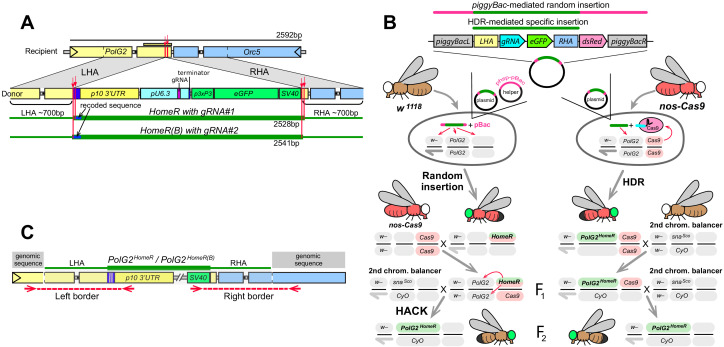
Site-specific integration of HomeR constructs at the PolG2 locus.(A) Schematic maps of the recipient (wildtype, wt) allele encompassing the area spanning PolG2 and Orc5 (CG7833) genes, and the donor allele harboring the HomeR or HomeR(B) gene drive element site-specifically integrated at the corresponding cut site. Each of HomeR and HomeR(B) contains one gRNA (Figure 1A) and is engineered to be integrated precisely into a specific cut site mediated by the gRNA it harbors via homology-directed repair (HDR). (B) Two separate approaches were used to generate transgenic lines harboring site-specific insertions of HomeR or HomeR(B) at the Drosophila PolG2. In the first approach, two plasmids, one carrying the HomeR construct and the helper plasmid (phsp-pBac;
Handler and Harrell, 1999) carrying the piggyBac transposase, were injected into w1118 embryos to generate transgenic lines harboring a random piggyBac-mediated integration tagged by double fluorescence (GFP+ and dsRed+). Then transgenic males (GFP+, dsRed+) were crossed to nos-Cas9 females (dsRed+) to generate site-specific PolG2HomeR transgenic lines, tagged by GFP alone, using Homology Assisted CRISPR Knock-in (HACK; Lin and Potter, 2016). In the second approach, the plasmid harboring the HomeR genetic construct was injected alone into nos-Cas9 embryos (dsRed+) and site-specifically integrated via HDR to generate F1 heterozygous PolG2HomeR/+; nos-Cas9/+ males with double fluorescence (GFP+ and dsRed+). In both approaches, F1 transgenic males harboring PolG2HomeR (GFP+) and nos-cas9 (dsRed+) were crossed to the second chromosome balancer line, w1118; CyO/snaSco, to balance and isolate the PolG2GDe insertion (GFP+). While both techniques (random insertion/HACK and HDR) worked to generate site-directed insertions, all subsequent analyses were performed exclusively on lines derived from the HDR approach. (C) To confirm site-specific integration of both PolG2HomeR and PolG2HomeR(B), the left and right borders between either HomeR or HomeR(B) genetic construct and Drosophila genomic sequence around the integration site were sequenced.